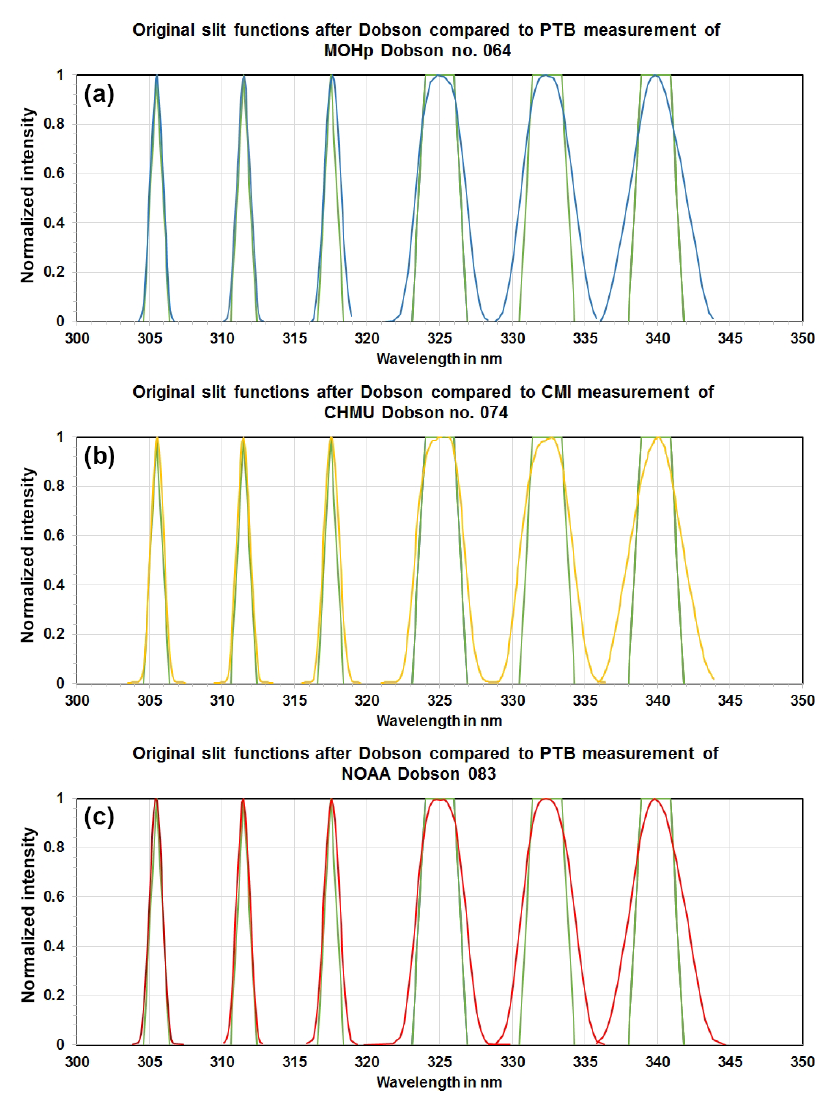
Figure 4. All slit functions of all short (three curves on the left side) and long wavelengths (three curves on the right side) for Dobsons No. 064 (a) , No. 074 (b) , and No. 083 (c) compared with nominal slit functions after